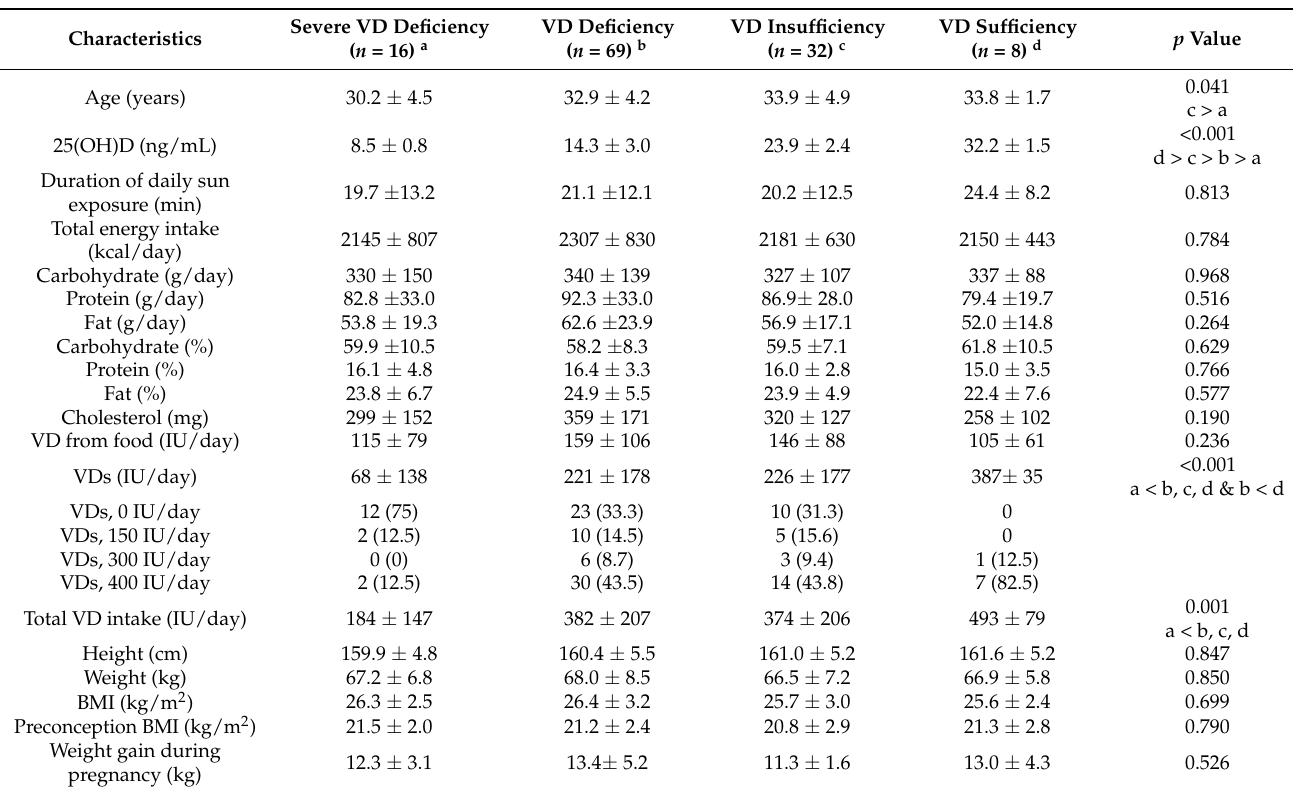
Table 3. Demographic, dietary, and anthropometric characteristics and vitamin D levels of the study participants stratified based on vitamin D status.